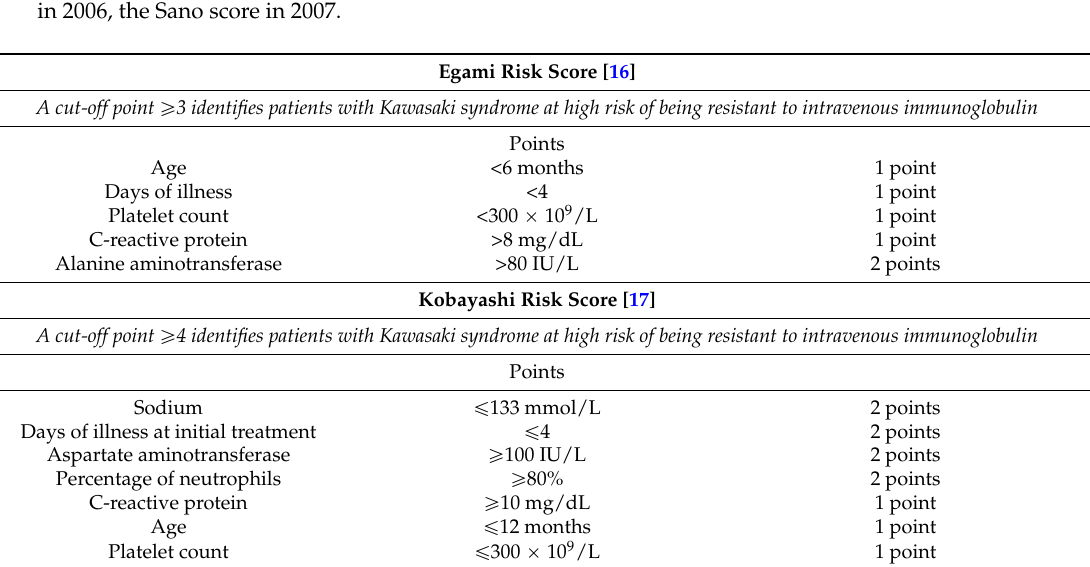
Table 1. The latest scoring systems evaluating non-responsiveness to treatment with intravenous immunoglobulin in children with Kawasaki syndrome: the Egami and Kobayashi scores were primed in 2006, the Sano score in